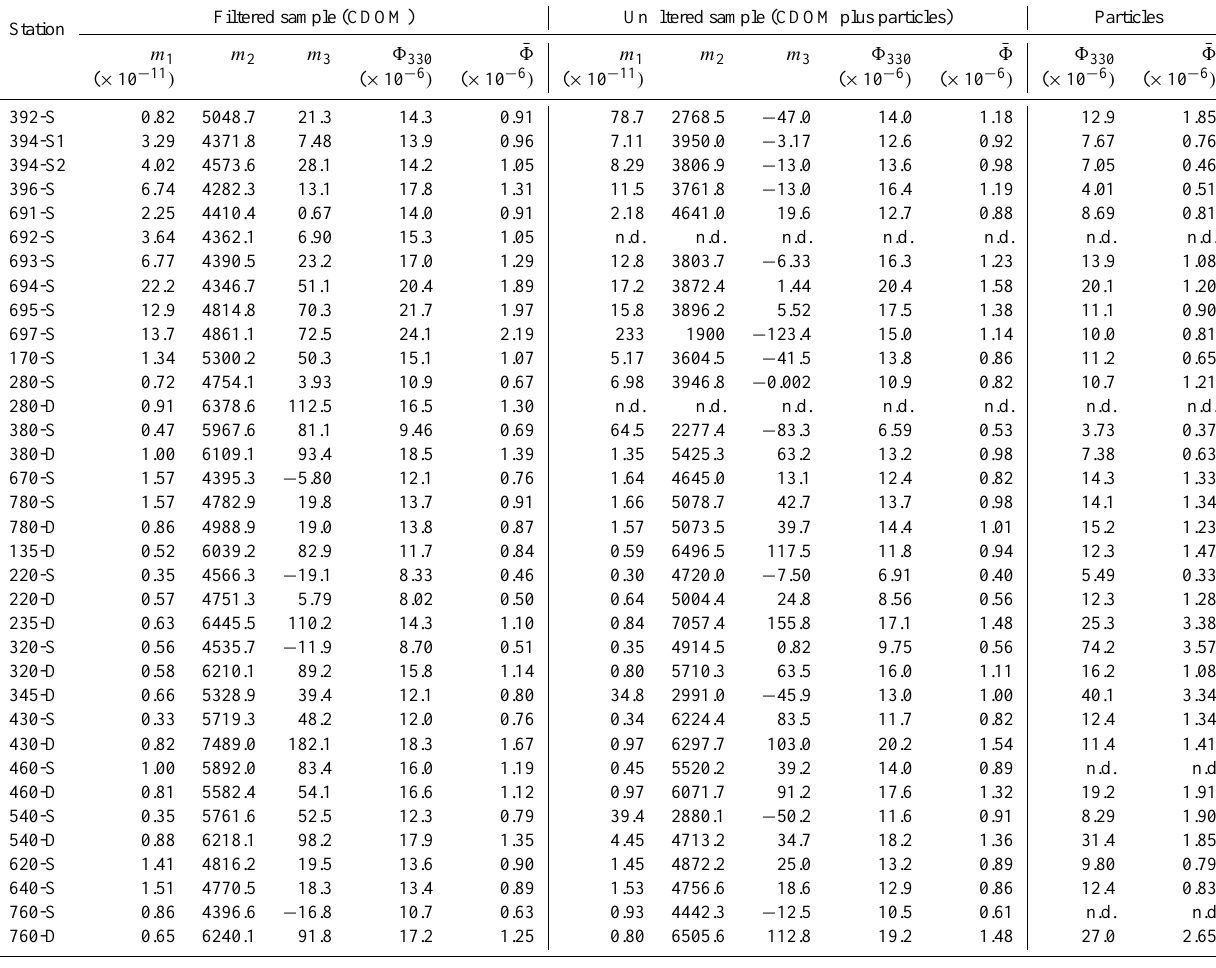
Table 3. Fitted parameters for equation 8 λ = m 1 × exp (m 2 /(λ + m 3 )) (Eq. 4 in the text) for filtered (CDOM) and unfiltered (CDOM plus particles) samples, along with 8 330 and ¯ 8 for CDOM, CDOM plus particles, and particles. n.d. = not determined. The uncertainty for 8 330 and ¯ 8 was estimated to be ± 4.5% based on the combined variability of CO and light intensity measurements.